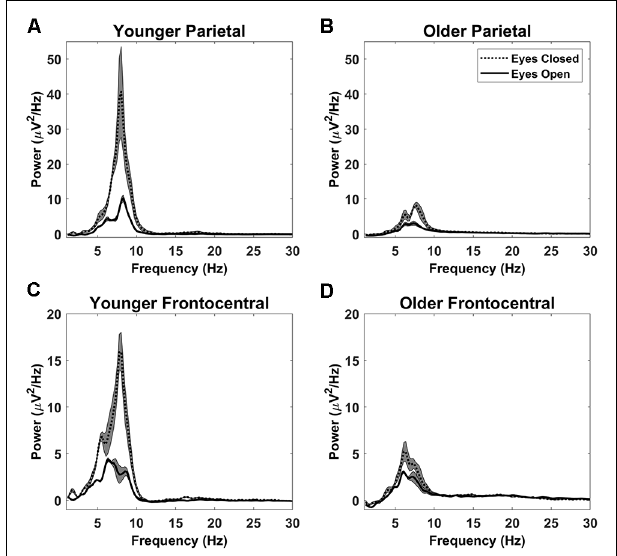
FIGURE 3 | Detrended power spectra: detrended power spectra at the parietal (A,B) and frontocentral (C,D) electrode subsets for younger adults (A,C) and older adults (B,D) . Shaded gray areas indicate +/ − the standard error. Note that younger adults had greater alpha power than older adults with both eyes open and eyes closed. However, theta power was not significantly different between younger and older adults. Both alpha and theta powers were reduced by opening the